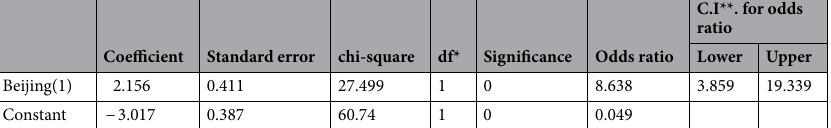
Table 5. Results of multiple logistic regression analysis showing the association of Beijing isolates of MTBC with multiple drug resistance (MDR). The dependent variable was MDR, and the independent variable was Beijing and non-Beijing strains of MTBC. *Degree of freedom; **95% Confidence